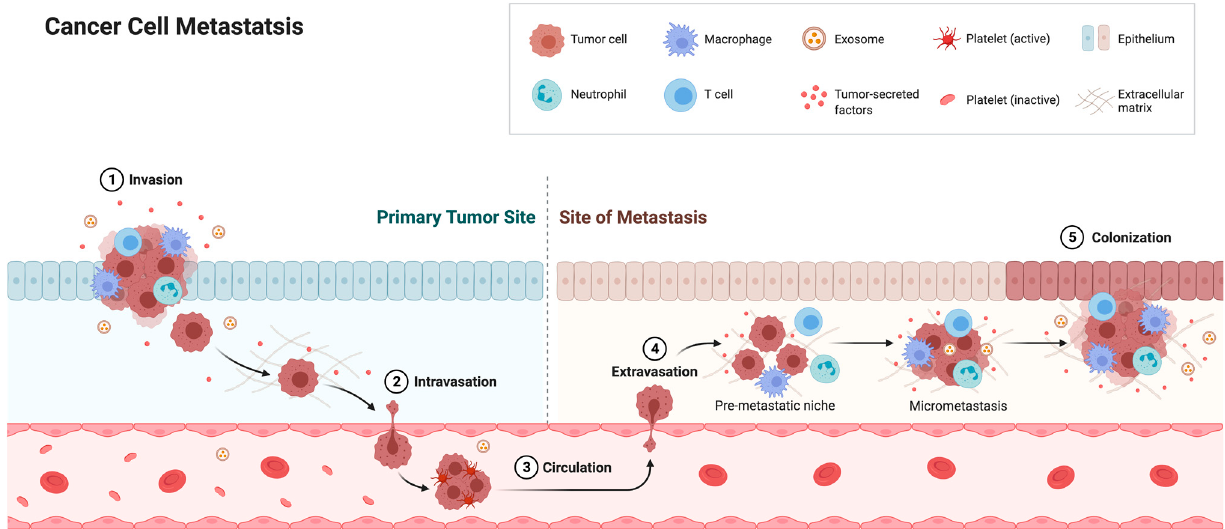
Figure 4. Cancer cell migration and metastasis. Cancer cells grow and invade the surrounding vasculature. Intravasation requires cells to undergo extensive deformations to squeeze through pores between 1 and 5 µm in diameter. Cells travel to a distant metastatic site, where they extravasate and proliferate [256]. Created with BioRender.com.